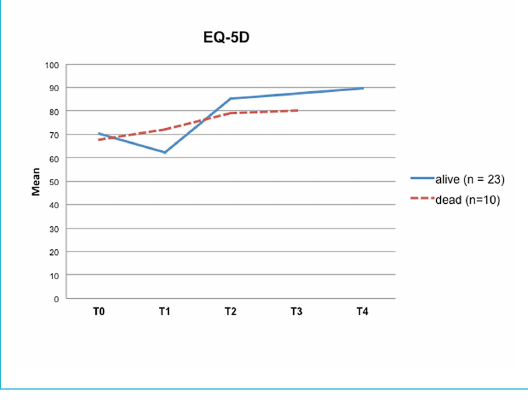
Figure 1: Health-related quality of life over time (T0 – T4). T0 = pre-transplant; T1 = two weeks post-transplant; T2 = three months